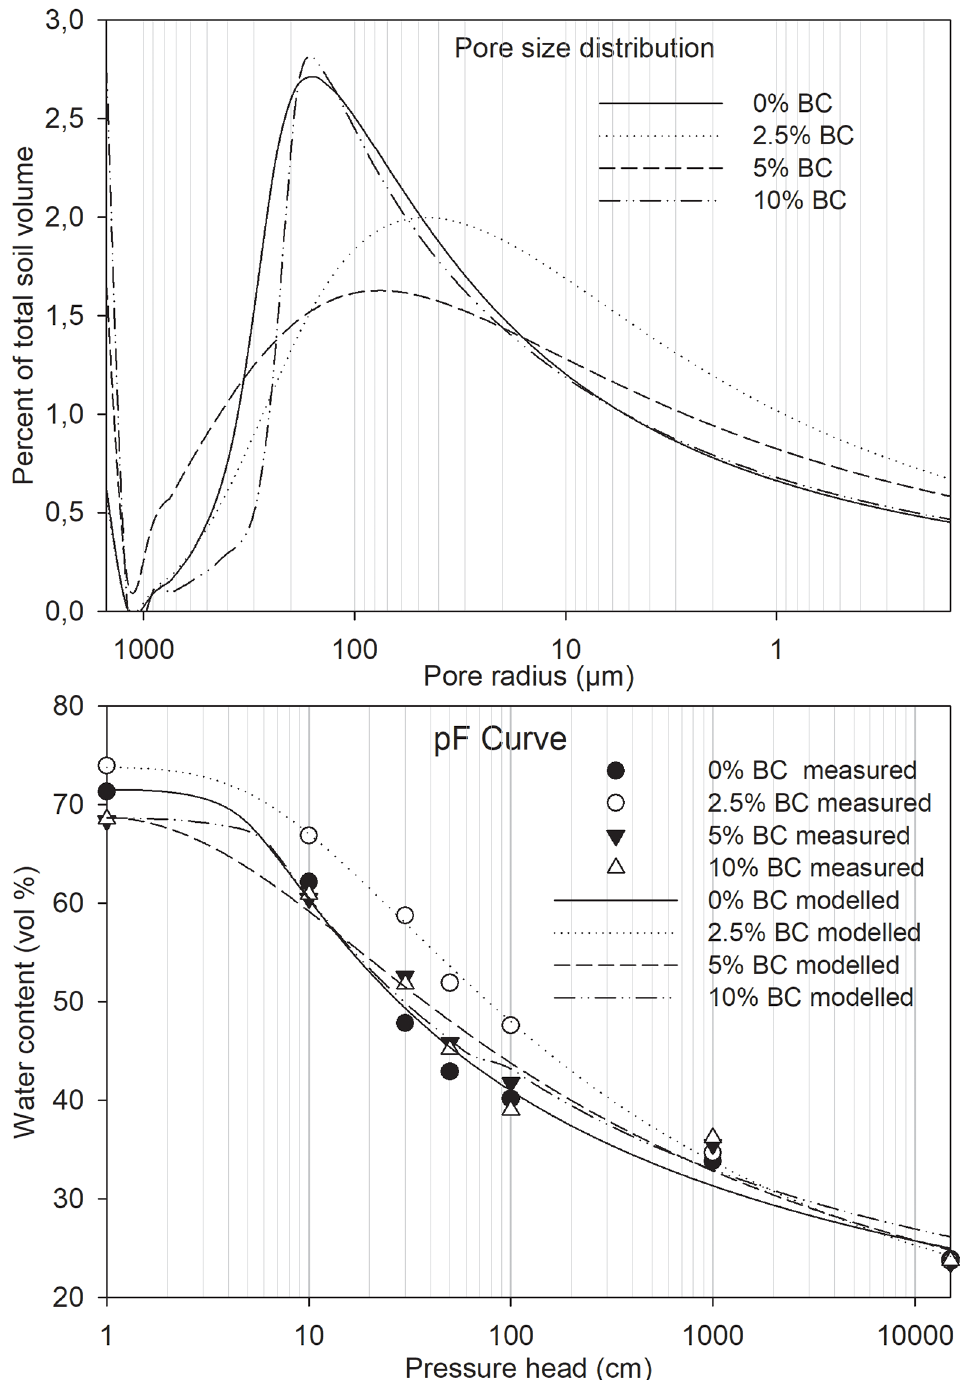
Fig 3. Water characteristic curves (pF) and pore size distribution of heavy clay soil amended with Eupatorium BC. The pore radius correspond directly to the pressure head in the pF curve. The distribution of pores < 0.1 μm, which constituted ~25% of the total soil volume is not shown because water held by these pores is not available to plants. The soil is from plough layer of heavy clay in West Timor, Indonesia.